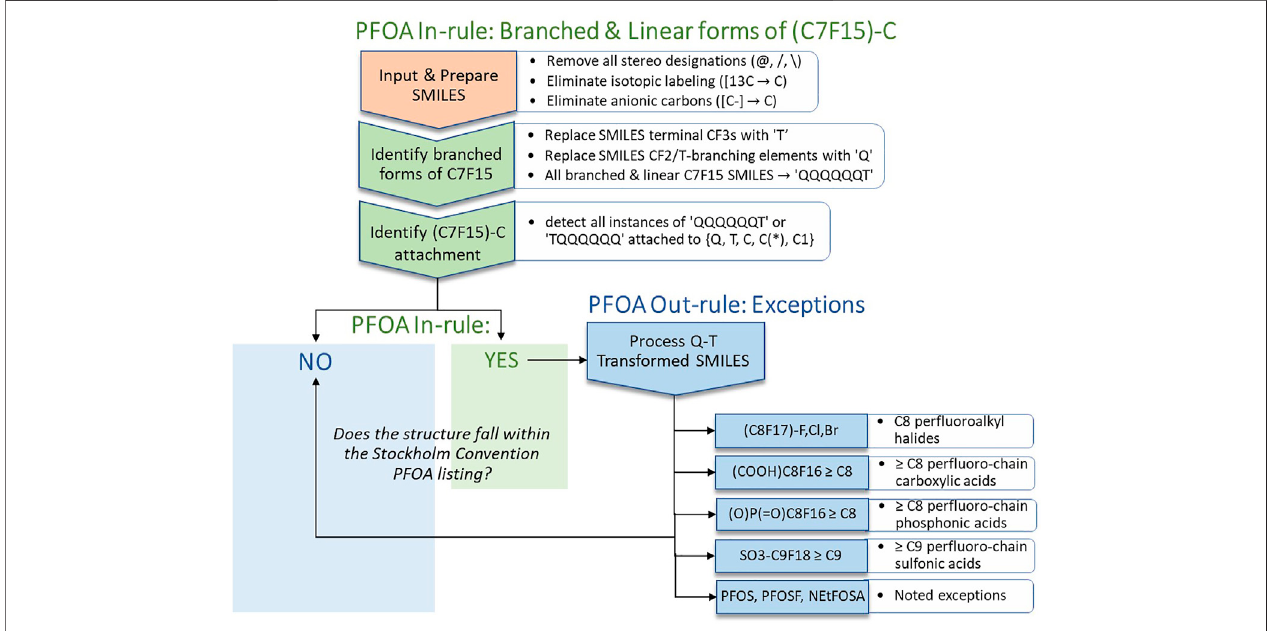
FIGURE2| SchematicillustrationoftheSMILES-basedimplementationofthePFOAIn-ruleandPFOAOut-rulework fl owstepsleadingtoassignmentofastructure (or list of structures) represented as SMILES (exported from EPA ’ s CompTox Chemicals Dashboard in JChem canonicalized format) as either YES (falling within the Stockholm Convention PFOA listing, with exclusions) or NO (not falling within the Stockholm Convention PFOA listing).